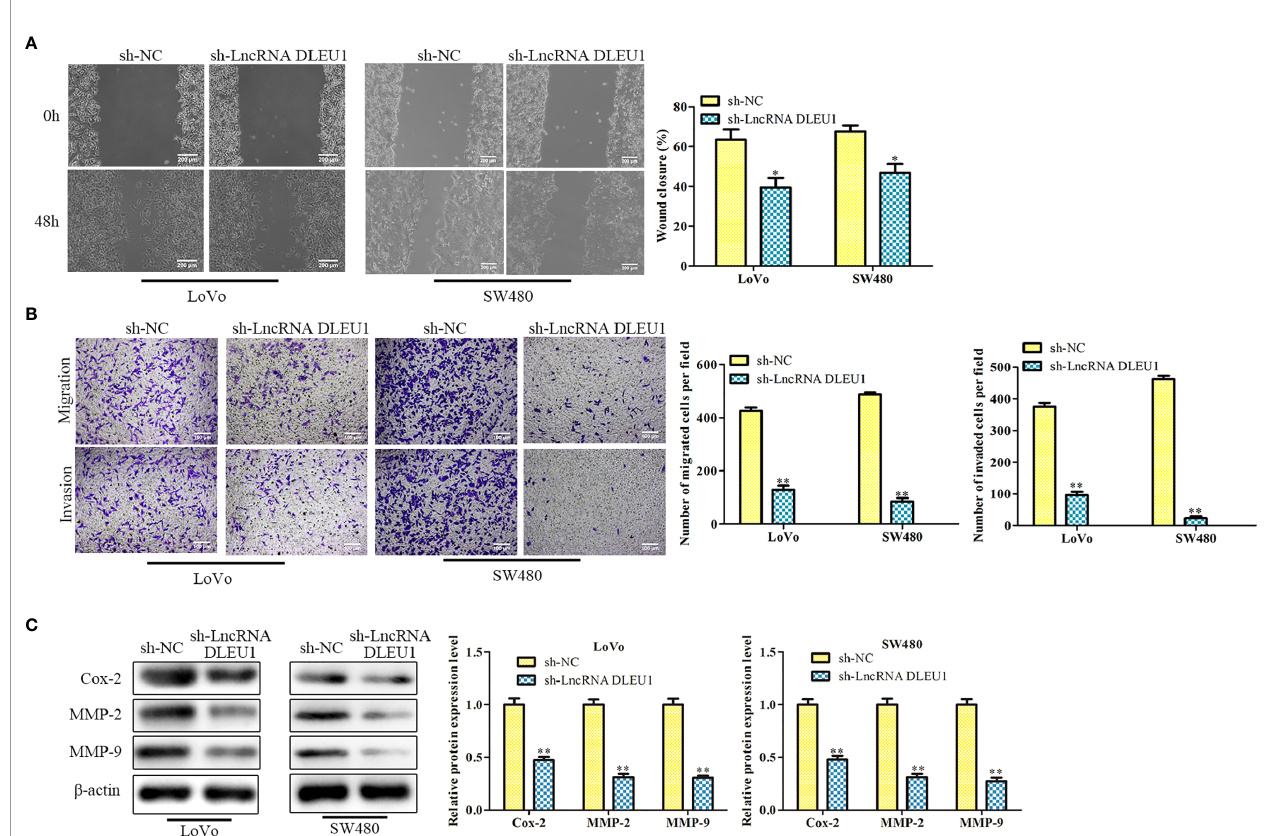
FIGURE 3 | Knockdown of DLEU1 represses cell migration and invasion. (A) The cell migration was determined by wound-healing assay in LoVo and SW480 cells. (B) The cell invasion was determined using transwell assay in LoVo and SW480 cells. (C) The invasion-related protein levels of Cox-2, MMP-2 and MMP-9 were investigated by western blot in LoVo and SW480 cells. * P < 0.05, ** P < 0.01 vs .